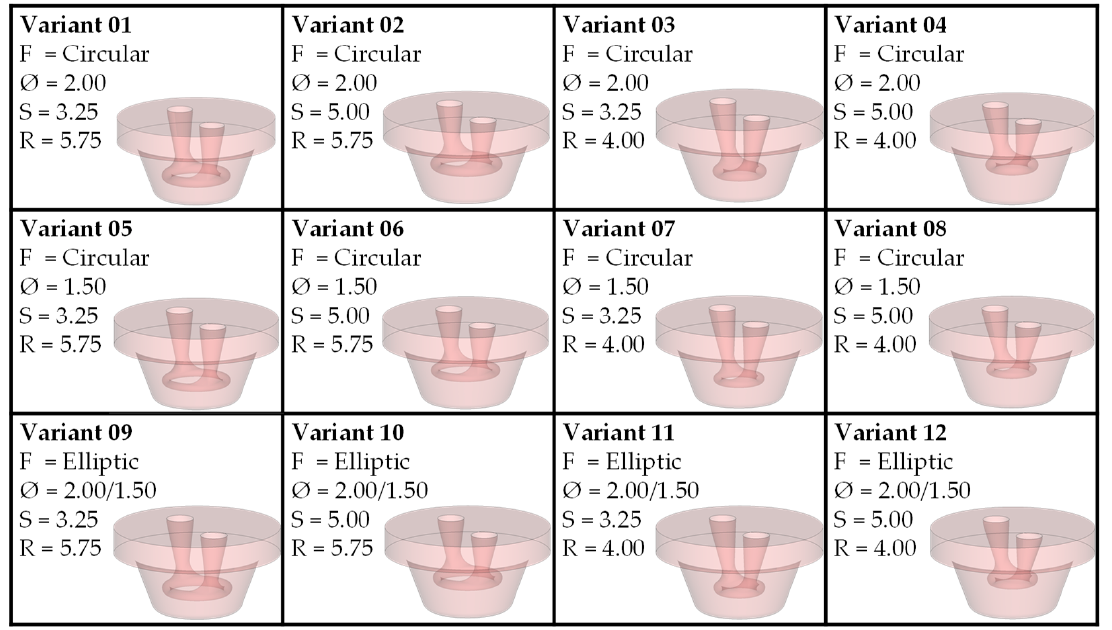
Figure 7. Overview of different channel geometries in the mandrel area (F = form of cooling channel; Ø = channel diameter (mm); S = surface distance (mm); R = rotation axis distance (mm)).